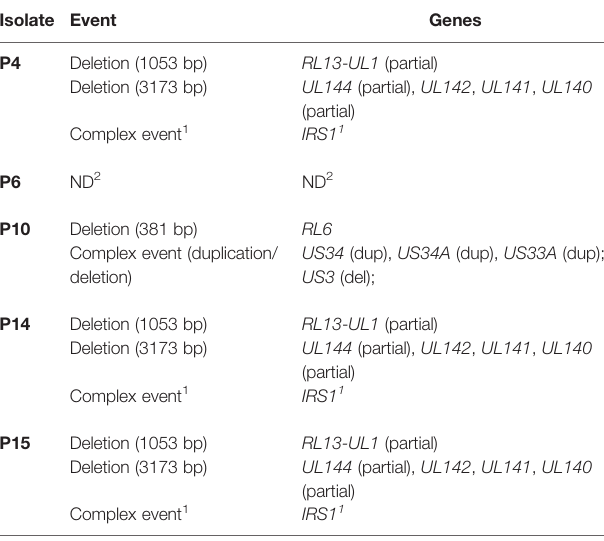
TABLE 1 | Genes containing ORF-disrupting